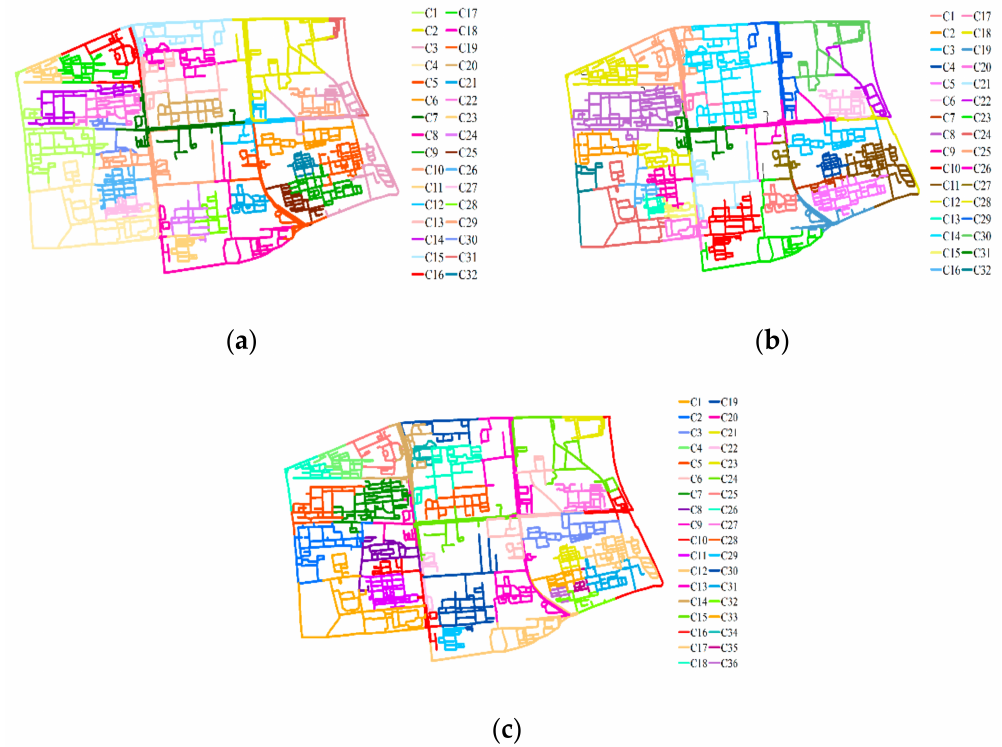
Figure 5. Communities identified by FacetNet: ( a ) snapshot 1; ( b ) snapshot 2; ( c ) snapshot